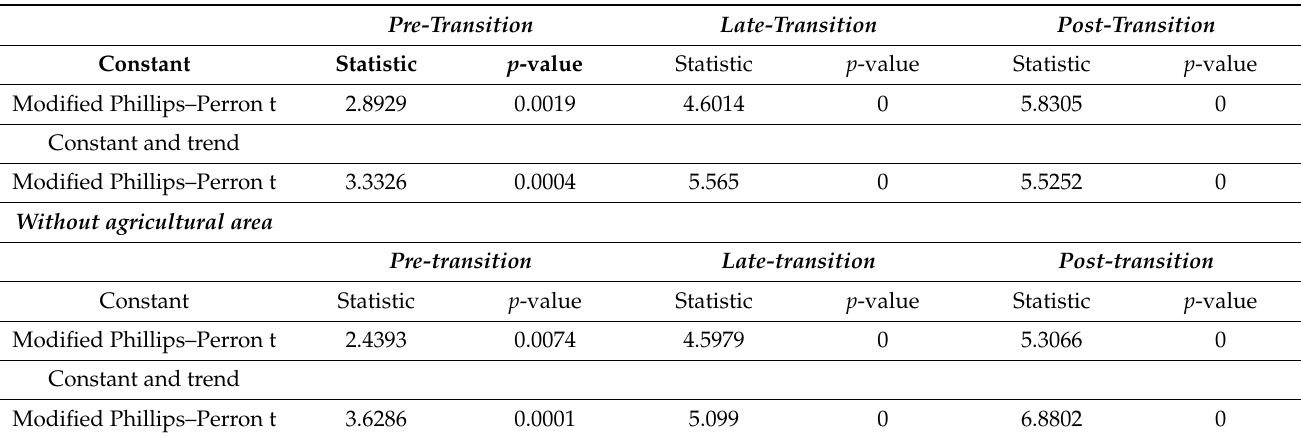
Table A15. Cointegration test, forest transition